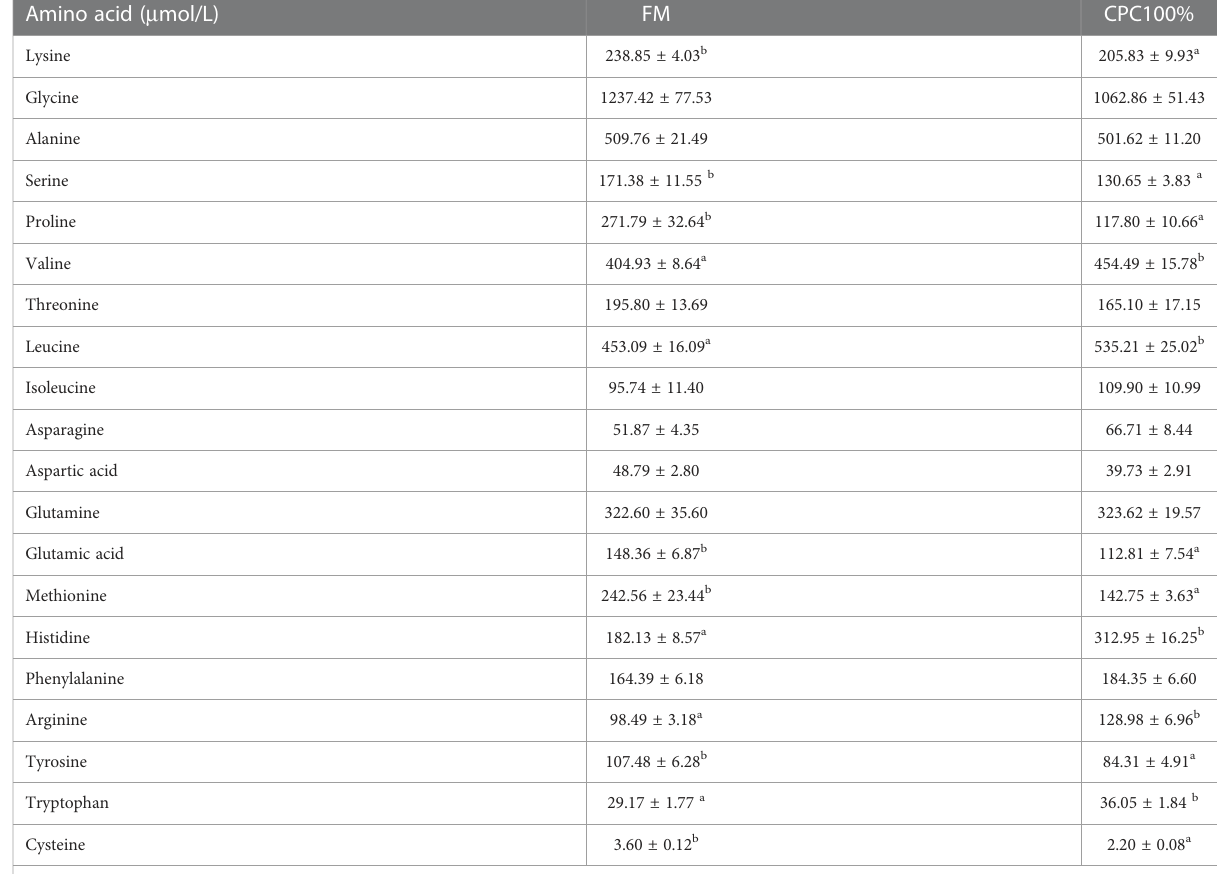
Values with different superscripts in the same column are signi fi cantly different